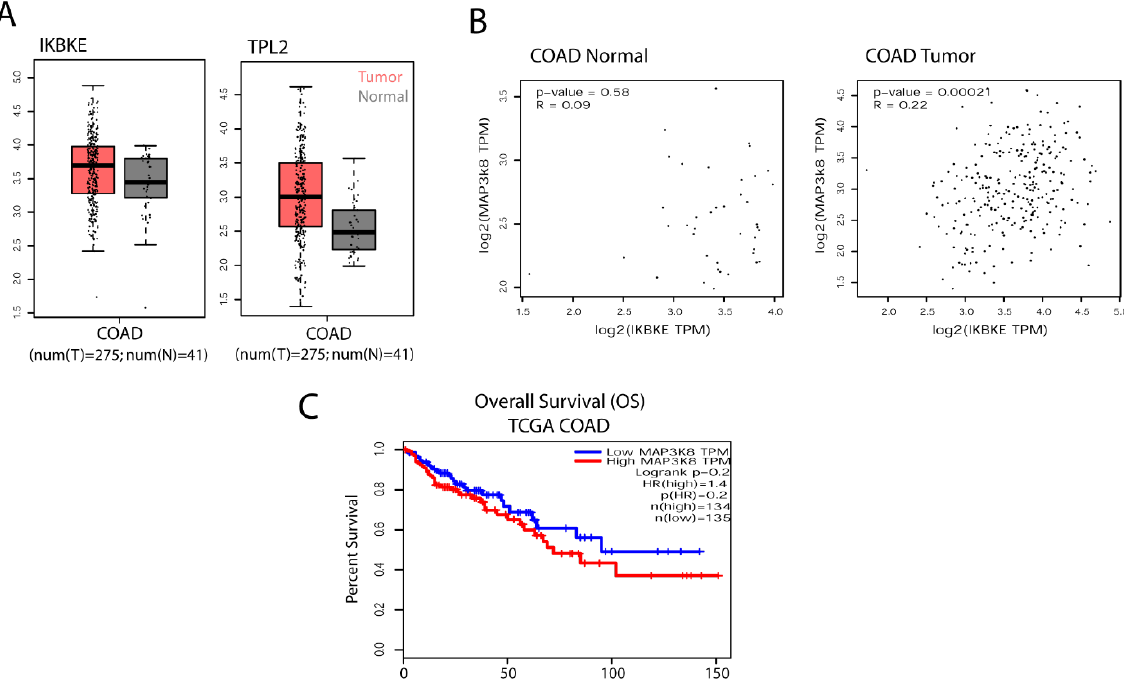
Figure 5: IKKɛ vs TPL2 expressions in TCGA colon adenocarcinoma (COAD) patient samples. (A) Tumor vs normal tissue IKKɛ and TPL2 expressions in TCGA COAD patient samples were pre- sented in scatter plot and boxplot (no significant differences between tumor vs. normal tissue were ob- served). (B) IKKɛ/TPL2 co-expressions were analyzed by Pearson correlation coefficient in GEPIA where expressions of the genes were only significantly correlated in tumor samples. (C) COAD patient overall survival (OS) Kaplan-Meier graphs (KM-plot) were obtained for TPL2 high vs. low patients ac- cording to TCGA data in GEPIA (no significant difference was